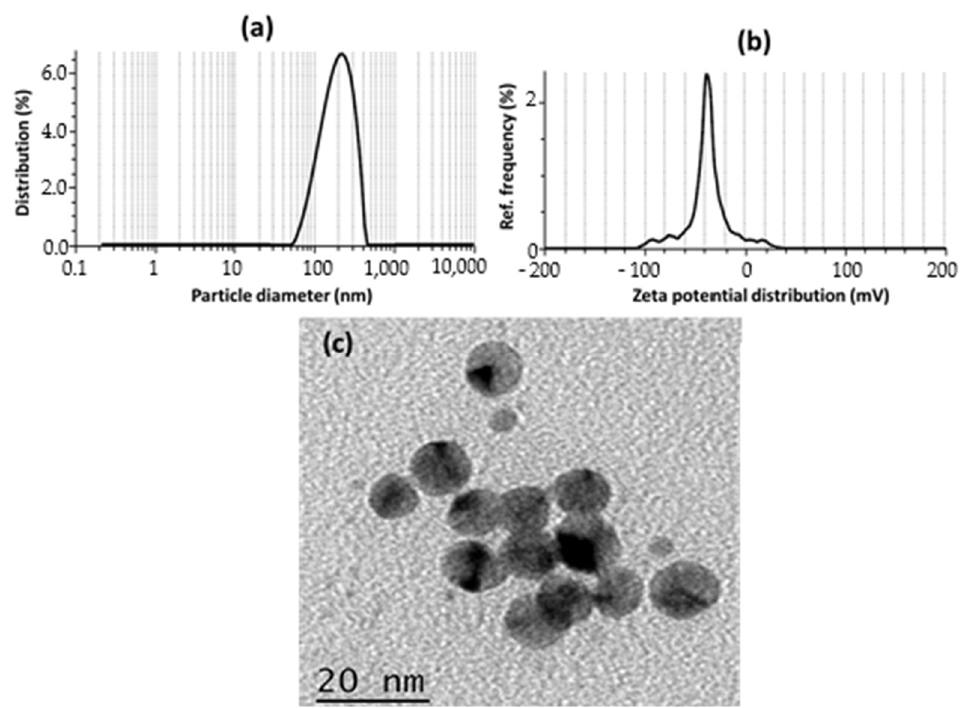
Figure 1. Evaluation of caraway essential oil’s nanoemulsion ( a ) Particle size; ( b ) Zeta potential; ( c ) ( c ) morphololy analysis of caraway nanoemulsion by